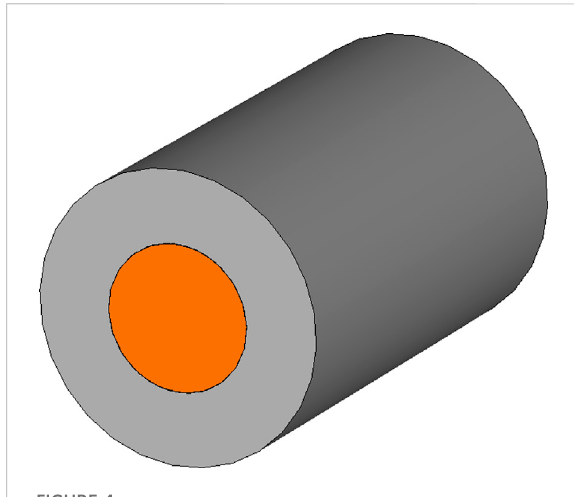
FIGURE 4 Geometry of the coaxial